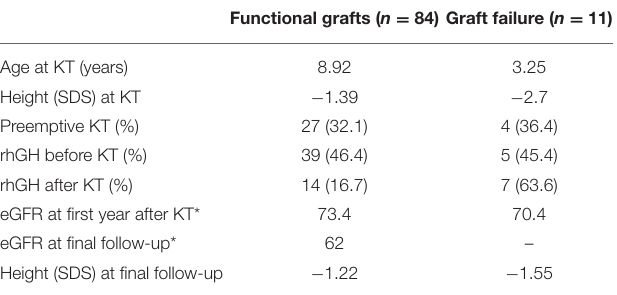
TABLE 2 | Patient characteristics according to graft status. TABLE 3 | Multivariate regression analysis for factors influencing SDS height one year after